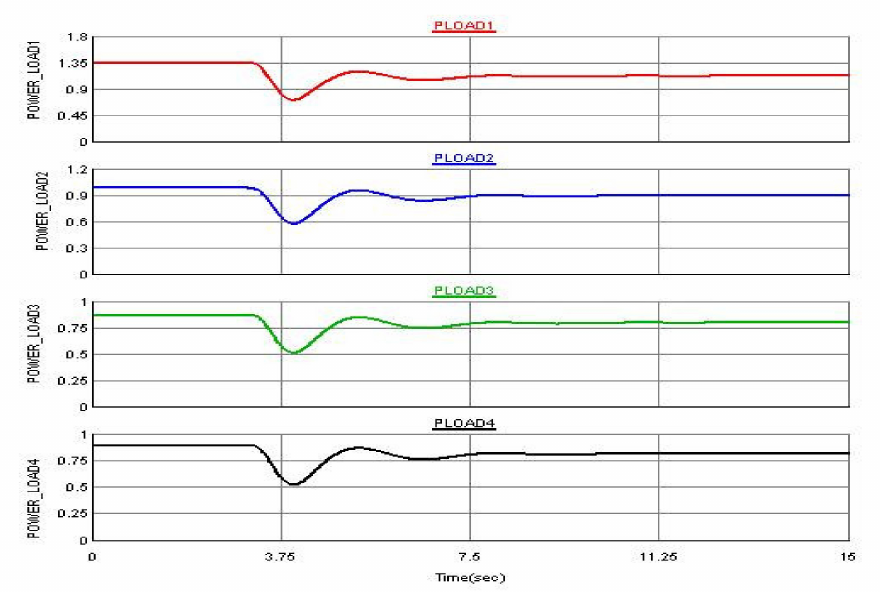
Figure 13. Non-critical load active powers (Loads at Buses 1–4).